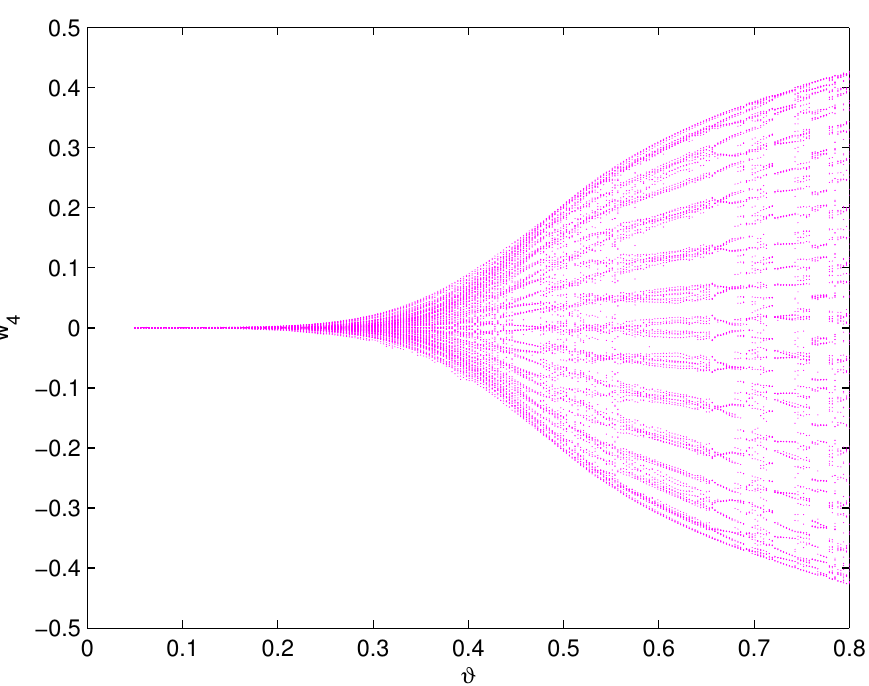
Figure 13. Bifurcation graph of system (72): the delay ϑ versus the variable w 4 . The bifurcation number is 0.44.